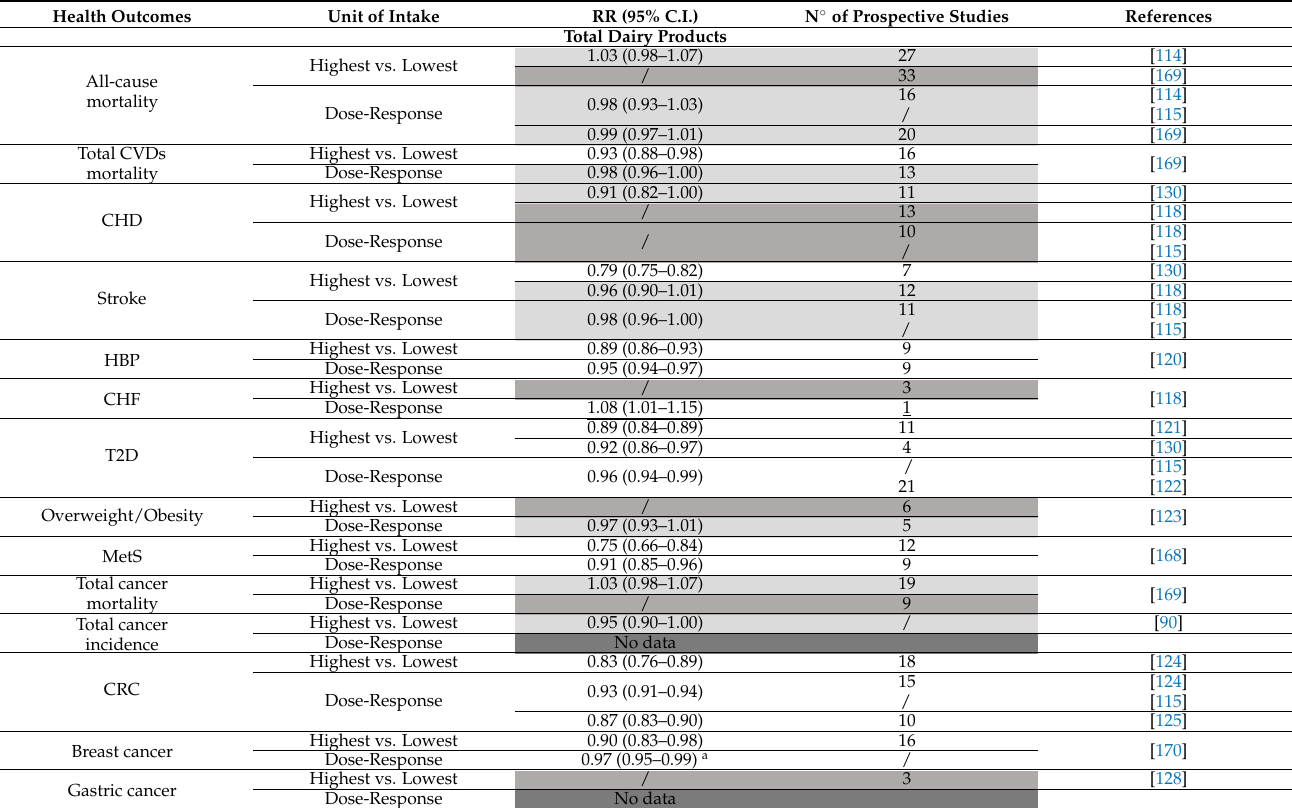
Table 6. Association between total dairy products, total milk, whole or skim milk, and yogurt intake and incidences of some major chronic diseases/mortality of major disease groups (RR, 95% C.I.). The dose-response meta-analysis always refers to an additional serving of a food per day relative to the average intake of that food observed in a cohort study (200 g for total dairy products and yogurt, 200 mL for total milk, whole milk, and skim milk).